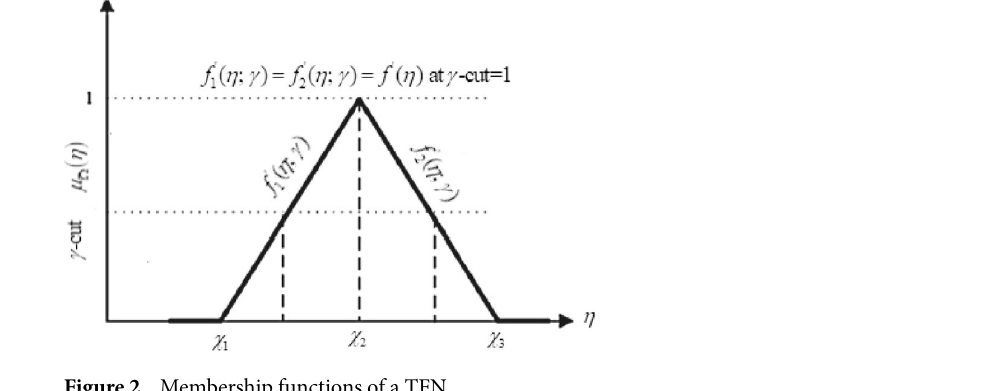
Figure 2. Membership functions of a